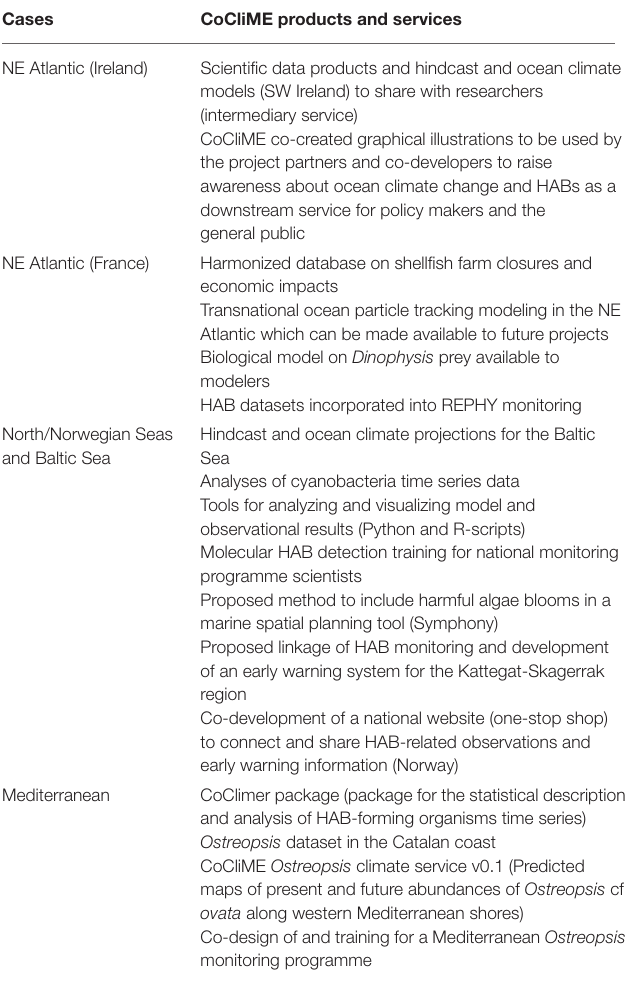
TABLE 3 | CoCliME prototype HAB-related climate products and services.